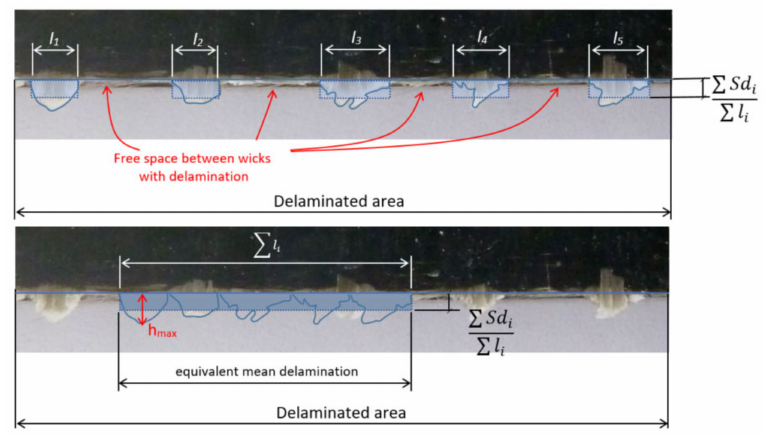
Figure 7. Equivalent delamination parameter (Wb) for Type II delamination.